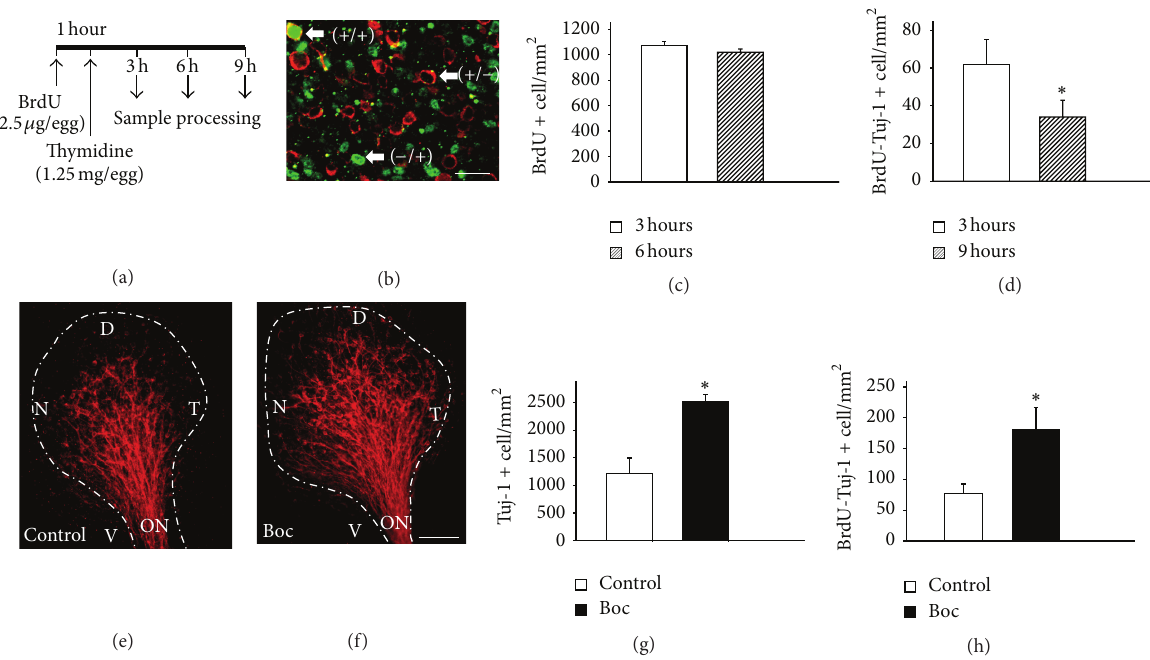
Figure 4: Effect of cell death on recently generated retinal ganglion cells. In HH21 chick embryos, in ovo window labeling (a) was used to visualize a defined population of recently generated neurons ((b); +/+ ; Tuj-1-positive in red; BrdU-positive in green). Proliferating cells ((b); −/+ ; BrdU-positivein green) were scored at different time points (c) to confirm complete closureof the window. Preexisting neurons were also visualized ((b); +/− ; Tuj-1-positive in red). Recently generated neurons were scored at different time points (d). Retinal whole mounts treated with Boc-D-fmk exhibited an expanded neuronal domain as compared with untreated retinas, as visualized by Tuj-1 immunostaining (e) and (f). Total neurons (g) and recently generated neurons (h) were scored in control and Boc-D-fmk-treated embryos. The main morphological features are labeled as follows: ON: optic nerve; D: dorsal; V: ventral; T: temporal; N: nasal. Scale bars represent 20 𝜇 m (b) and 80 𝜇 m (e), (f). Graphs represent the mean ± SD of at least 3 retinas from different embryos. ∗ 𝑃 < 0.005